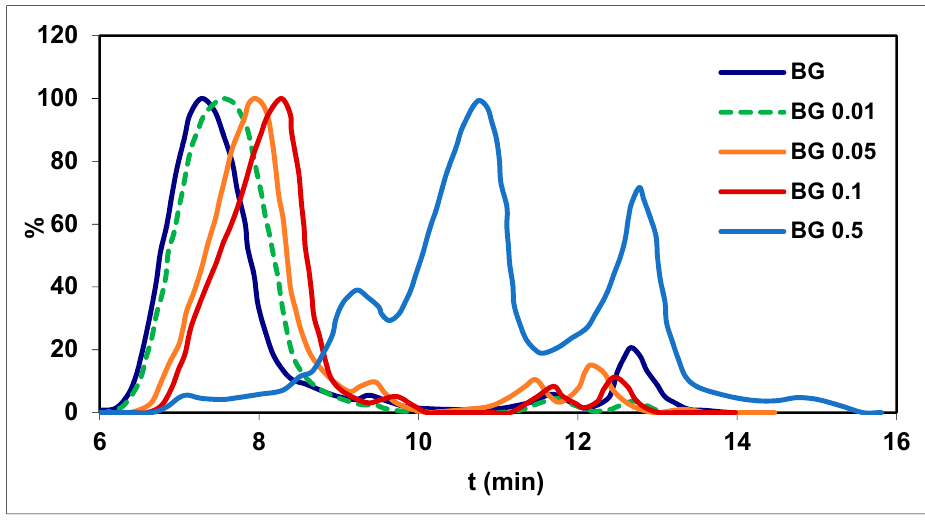
Figure 2. Chromatogram of BG and AG.